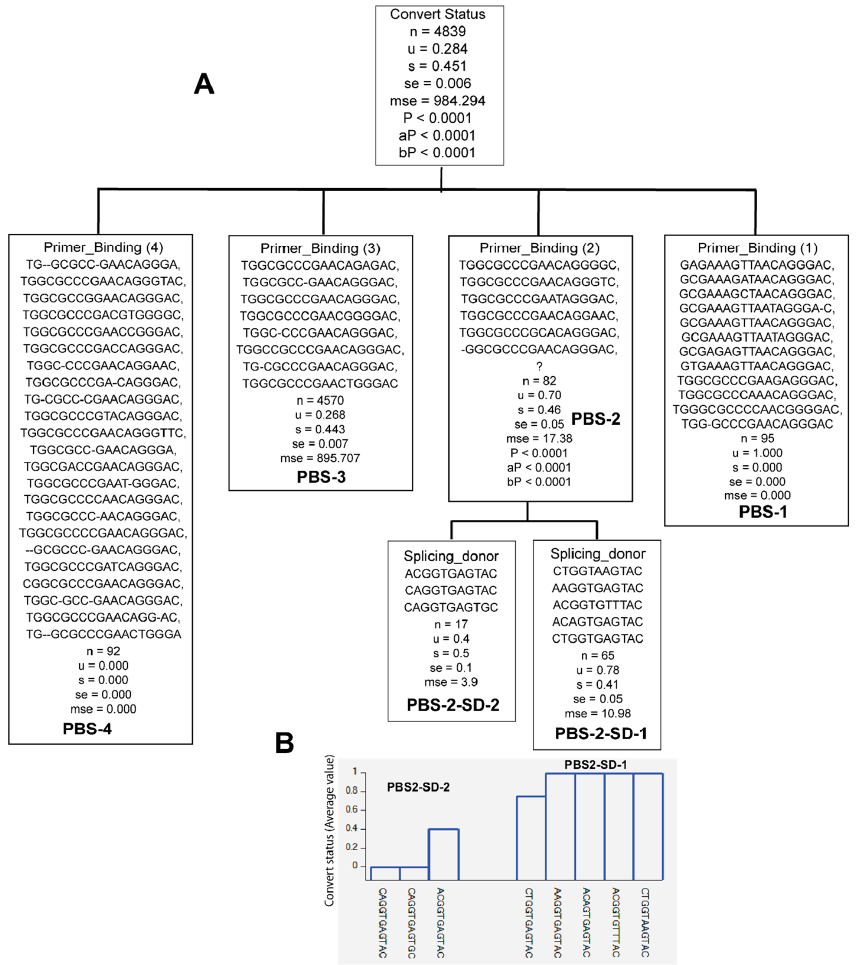
Figure 6. The combination of PBS variants (PBS-2) and splicing donor sequences identified only in either late ( u = 1) or early seroconverters ( u = 0). ( A ) PBS sequence variants in tree node of PBS-2 were further classified with SD sequence variants based on whether they were identified from late or early seroconverters; ( B ) the figure shows u value of sequence combinations based on whether the PBS-SD combinations were identified from late (1) or early (0) seroconverters. Note: n— counts (clone); u— mean value; s—standard deviation; se—standard error; mse—mean square error; p—p value; aP— adjusted p value; bP—Bonferroni corrected p value. “?” denotes lack of sequences”.